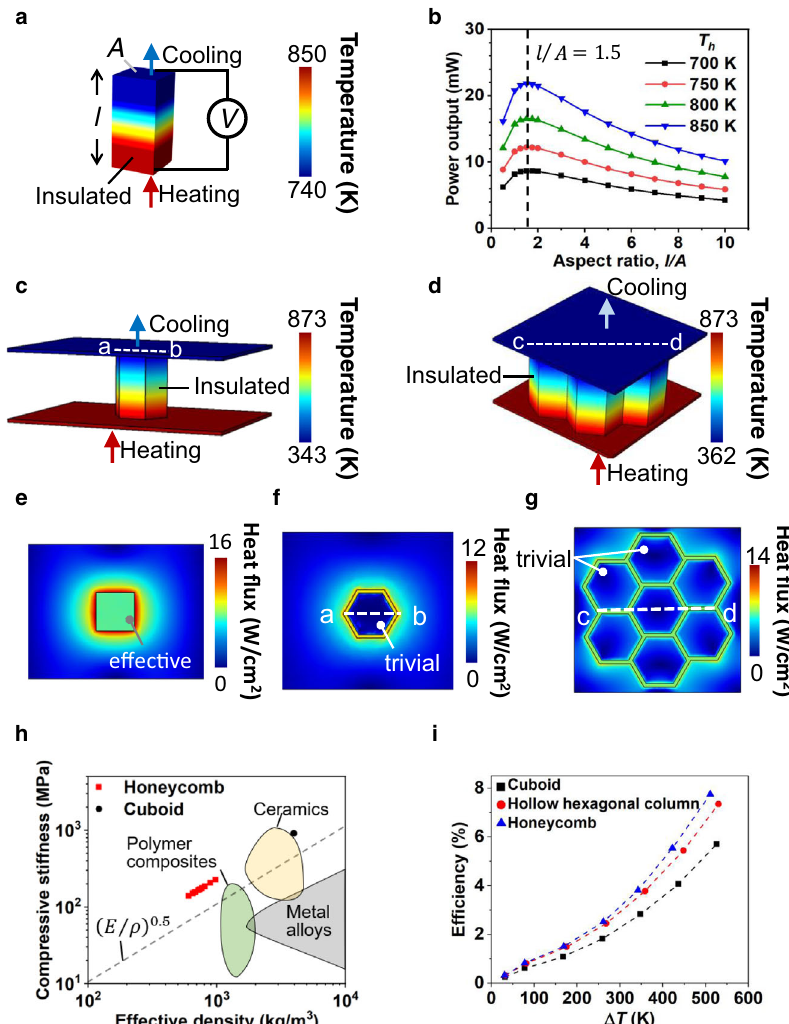
Fig. 1 Design of Cu 2 Se TE cellular architectures. a Simulated temperature distributions in cuboid-, -shaped Cu 2 Se TE legs. b Output power of cuboid- shaped Cu 2 Se TE leg as a function of aspect ratio. c, d Simulated temperature distributions in ( c ) hollow hexagonal column-, and ( d ) honeycomb-shaped Cu 2 Se TE legs. e – g Simulated heat fl ux distribution in the cold side of ( e ) cuboid-, ( f ) hollow hexagonal column-, and ( g ) honeycomb-shaped Cu 2 Se TE legs when the hot side temperature is 873 K. h Compressive stiffness-density Ashby plot showing the cellular Cu 2 Se materials described in this paper compared with other materials. I Generation ef fi ciencies of Cu 2 Se TE legs at the hot side temperatures ranging from 323 to 873